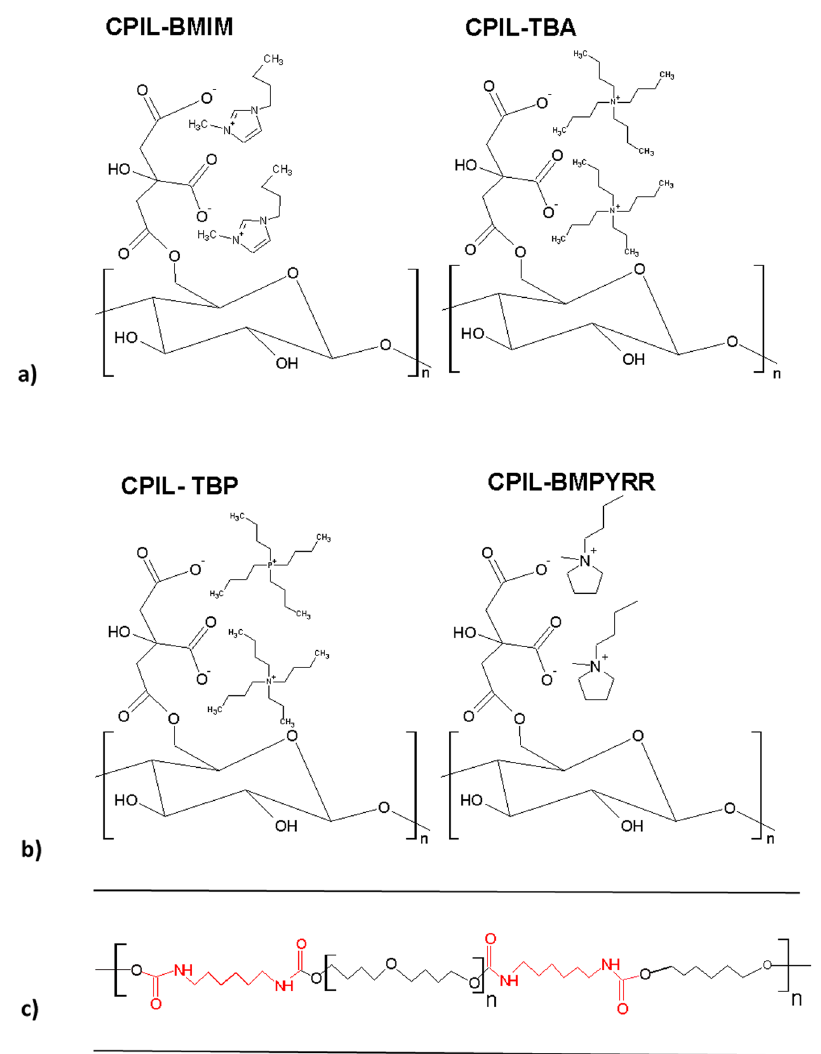
Figure 1. CPILs (a) and PU (a) chemical structure.